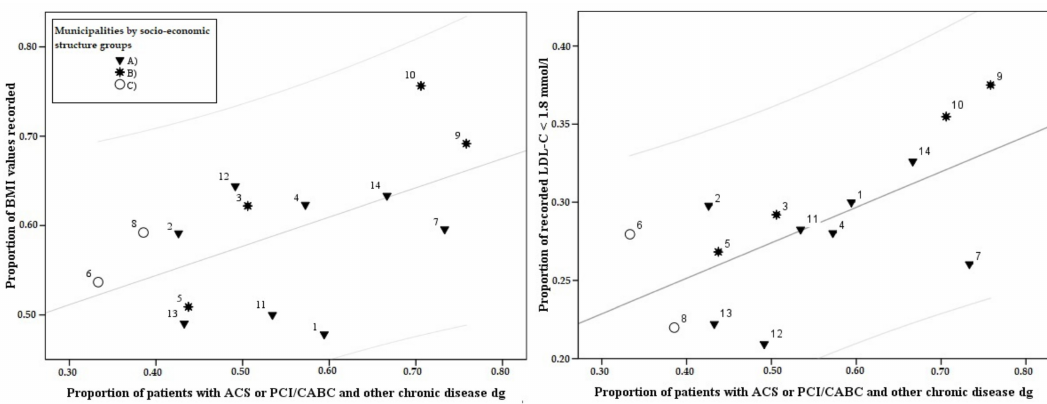
Figure 5. The municipality level associations between the proportion of multimorbid individuals and body mass index (BMI) follow-up rates and LDL-C management rates among patients with ACS and/or PCI/CABG in North Karelia Hospital District in 2011–2014. (BMI = body mass index, LDL-C = low-density lipoprotein cholesterol, ACS = acute coronary syndrome, PCI = percutaneous coronary